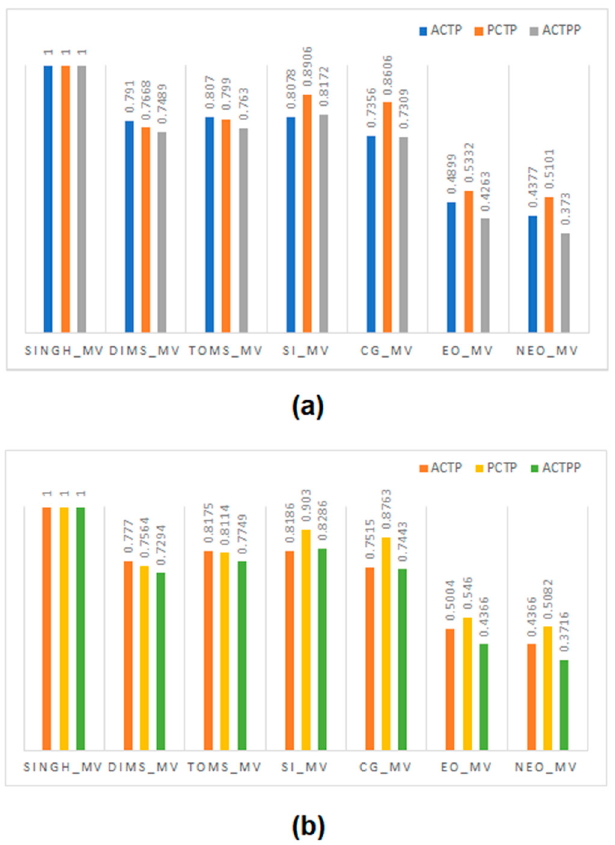
Figure 7. Normalized FOMs of TMR implementations utilizing different majority voters corresponding to: ( a ) RTZH; and ( b ) RTOH.